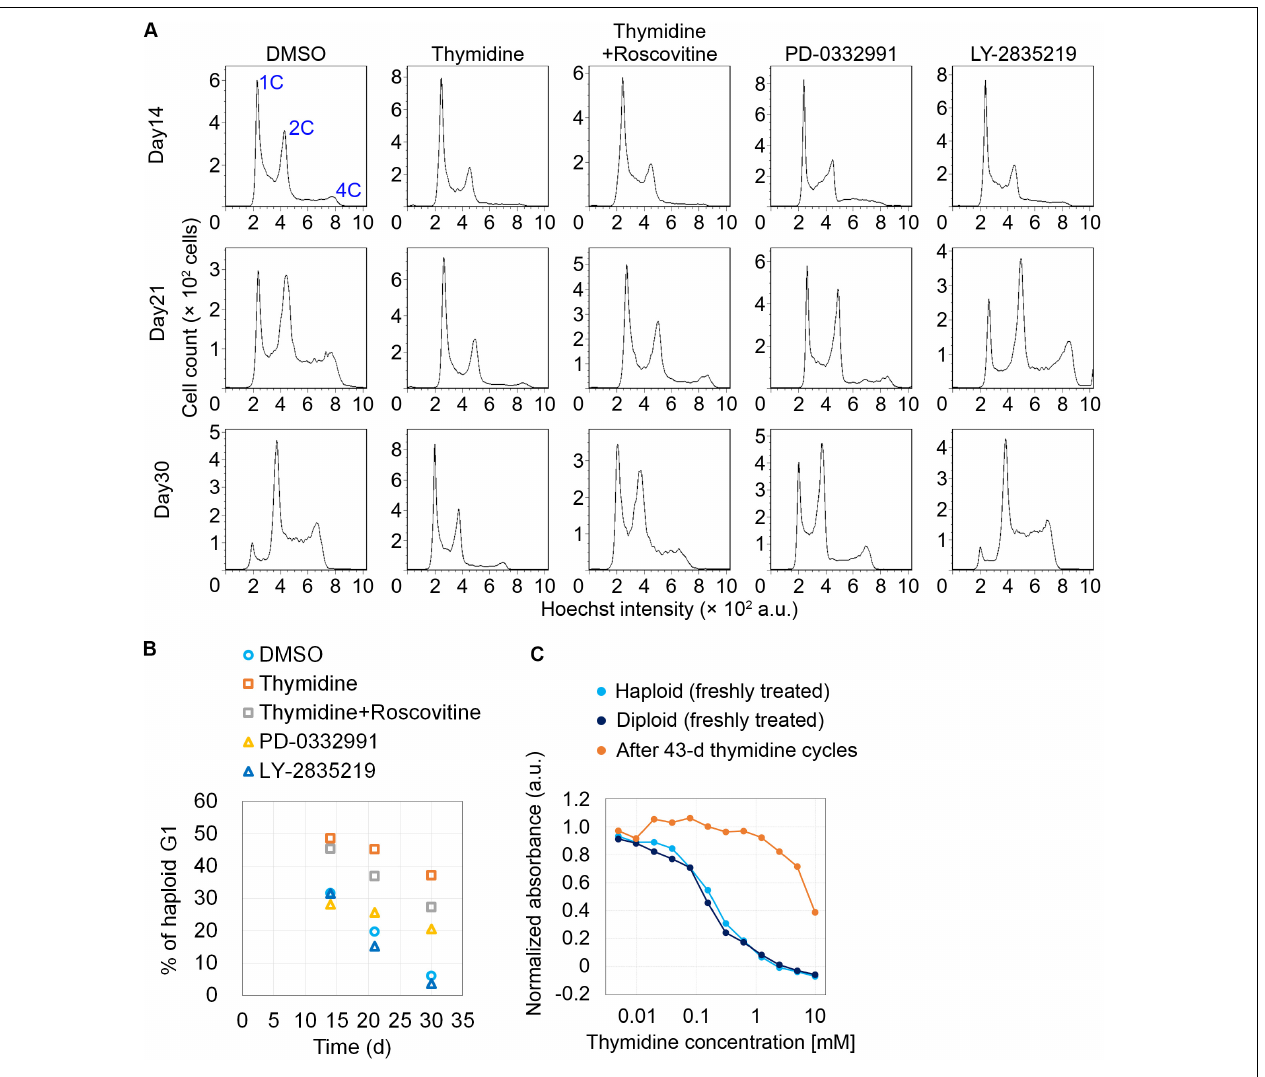
FIGURE 3 | Improvement of haploidy stability in G1/S phase-extended cells in long-term passages. (A) Flow cytometric analysis of DNA content in Hoechst-stained cells in the long-term passages with or without inhibitors treatment/release cycles. Representative data from two independent experiments. (B) Time course of haploid G1 frequency in panel (A) . Means of two independent experiments. (C) Colorimetric cell proliferation assay of HAP1 cells treated with different concentrations of thymidine before or after long-term thymidine treatment/release cycles. A representative result from two independent experiments is shown (means of